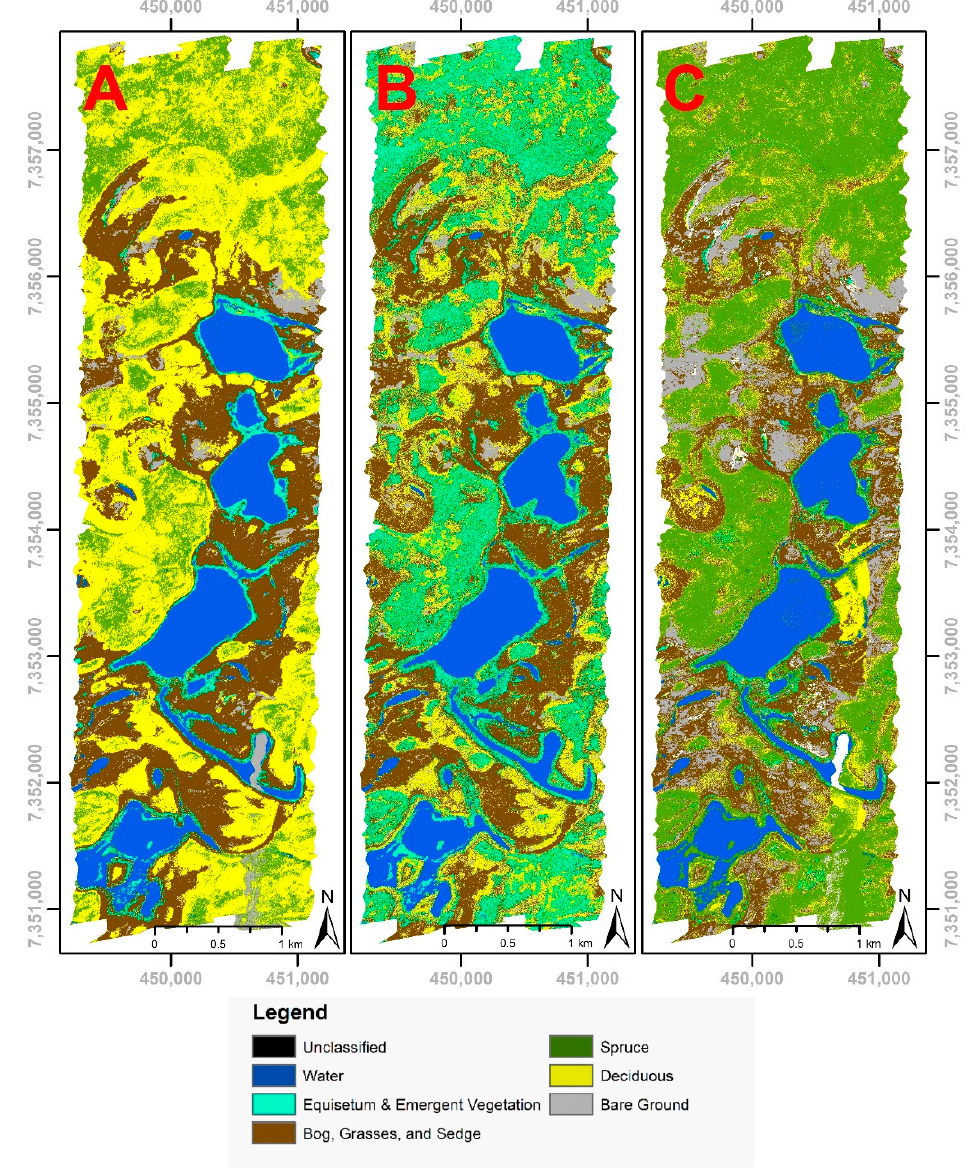
Figure 9. Wetland classification results for A area using a maximum likelihood classifier (right panel A), a Spectral Angle Mapper (SAM) classifier (middle panel B), and a hybrid classifier (left panel C).